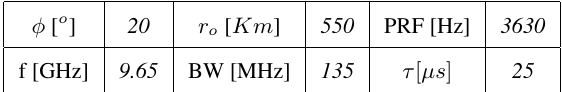
Table 3. Scenario configurations for simulations in Section 6.. Sea parameters are h